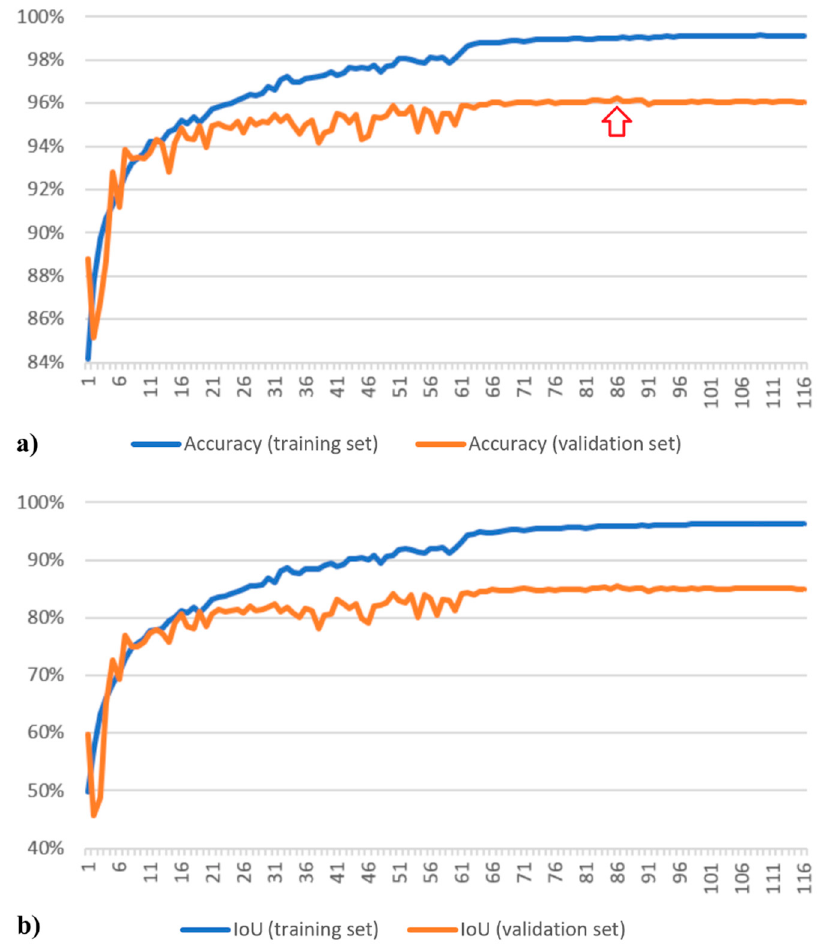
Figure 5. A sample accuracy ( a ) and intersection over union (IoU) ( b ) metrics charts showing values on the training and validation sets. The data are taken from the training of the fifth model with 32 initial filters. The red arrow in ( a ) depicts the best accuracy epoch when the model is saved.